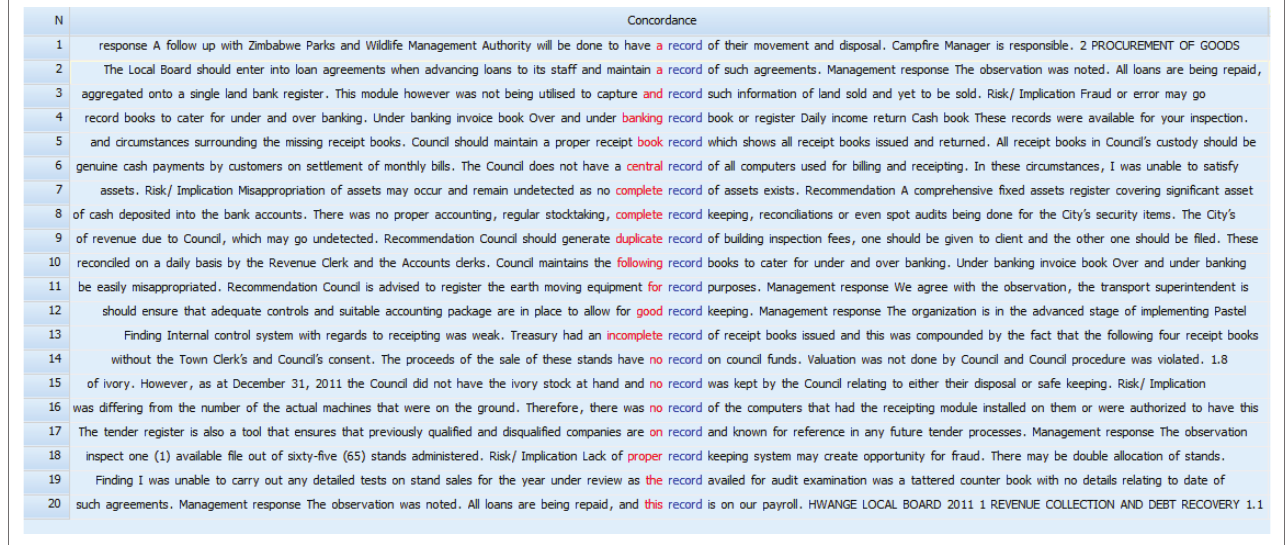
FIGURE 5: The Comptroller and Auditor General of Zimbabwe Narrative Report for the financial year ended 31 December 2012 for local